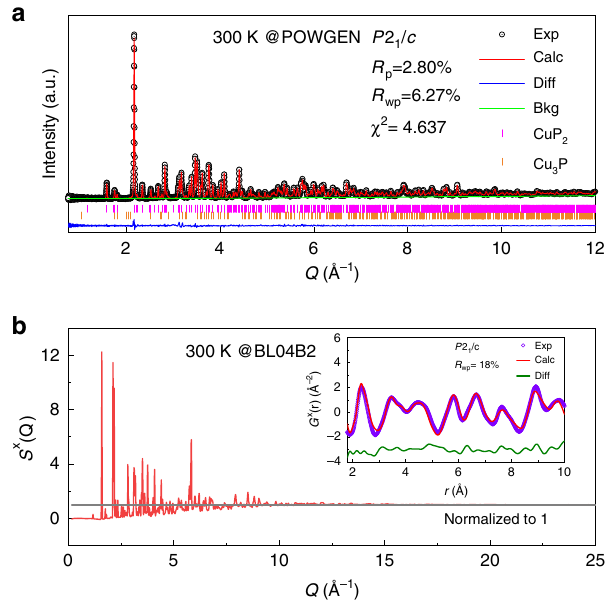
Fig. 2 Average and local structures of CuP 2 . a Neutron powder diffraction pattern and Rietveld re fi nement analysis at 300 K. b The structure factor, S X ( Q ), obtained in X-ray total scattering at 300 K. The inset is the reduced PDF, G X ( r ), as well as the real-space re fi nement based on the P 2 1 / c crystal